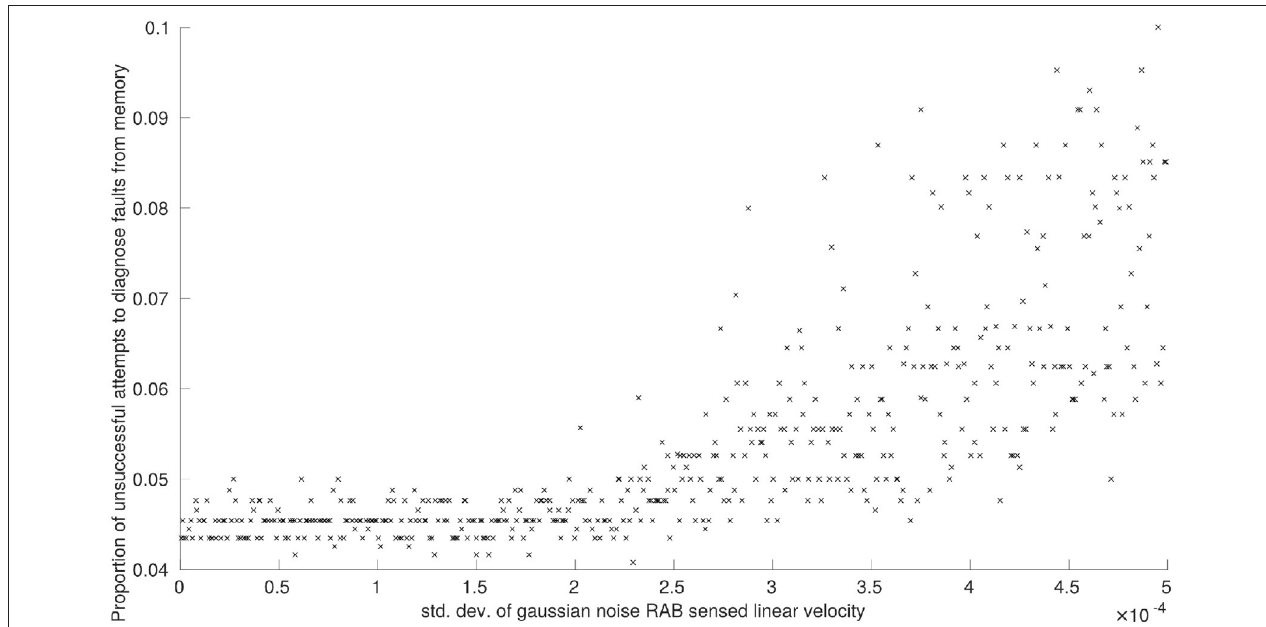
FIGURE 3 | The effects of noise on RAB sensed linear velocity measurements on the proportion of unsuccessful attempts to diagnose faults from